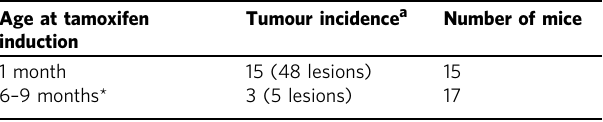
Fig. 5 Mouse and human β -catenin-accumulating clusters share a common signature of senescence and SASP. a – d Gene set enrichment analysis (GSEA) ( a , c ) revealing that clusters from both mouse models, the Hesx1 Cre/ + ;Ctnnb1 lox(ex3)/ + and Sox2 CrERT2e/ + ;Ctnnb1 lox(ex3)/ + ;R26 YFP/ + , show a molecular signature of oncogene-induced senescence (OIS) and senescence-associated secretory phenotype (SASP). qRT-PCR analysis showing the upregulation of several senescence and SASP factors in both mouse models ( b , d ). Bars in b and d represent the mean, and error bars represent standard error of the mean (SEM) of three biological replicates. * p < 0.05, ** p < 0.01, *** p < 0.001, Student ’ s t test. e Several cytokines are upregulated in the Hesx1 Cre/ + ; Ctnnb1 lox(ex3)/ + mutant relative to the Hesx1 + / + ;Ctnnb1 lox(ex3)/ + control pituitaries as measured in a mouse cytokine antibody array. f Gene set enrichment analysis (GSEA) demonstrating that laser-capture micro-dissected human clusters show a molecular signature of oncogene-induced senescence (OIS) and senescence-associated secretory phenotype (SASP). g Hierarchical clustering analysis of RNA-data sets from cluster and non-cluster cell populations indicating coherent grouping between speci fi c cell compartments. h , i GSEA of the top 100 or 500 most upregulated genes in human clusters and the whole transcriptome of mouse clusters from both models demonstrating a common molecular